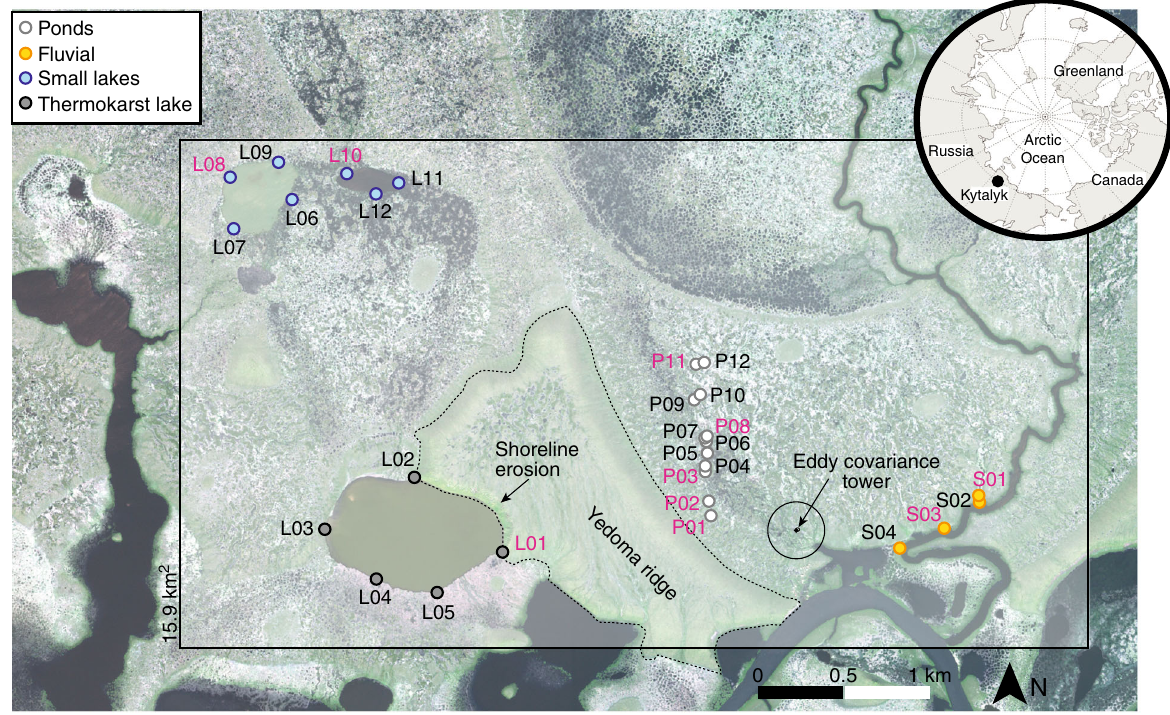
Fig. 1 Study region and sampling locations. Sampling locations for concentrations (black text) and radiocarbon (magenta text), eddy covariance tower (black dot) and its footprint (black circle represents 75 – 90% of fl ux contributions 44 ), Yedoma ridge (dashed black outline), and location of the site within the Arctic (inset). The box (15.9km 2 ) indicates the area used for upscaled fl uxes (Table 1). Background is a panchromatic Worldview satellite image from 15 July 2015, WorldView © 2019